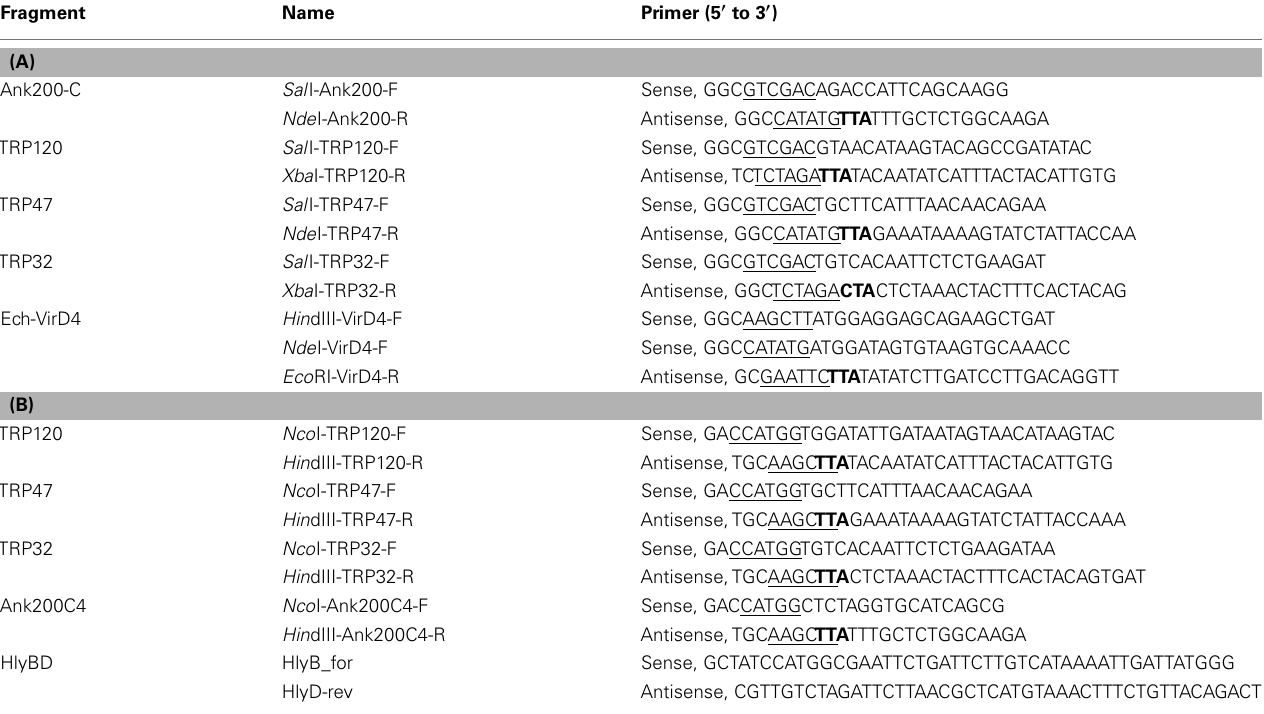
TableA2 | List of oligonucleotide primers used for (A)T4SS and (B)T1SS study. Fragment Name Primer (5 (cid:2) to 3 (cid:2) )